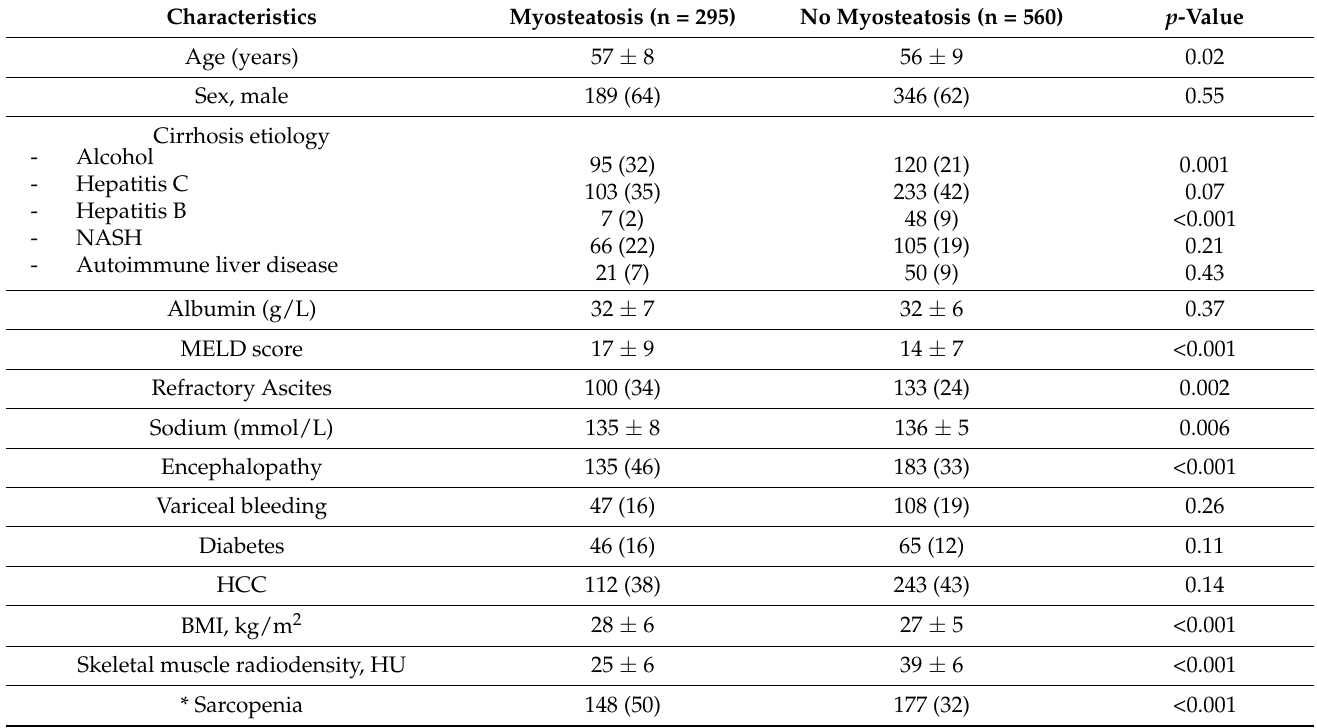
Table 2. Clinical features associated with